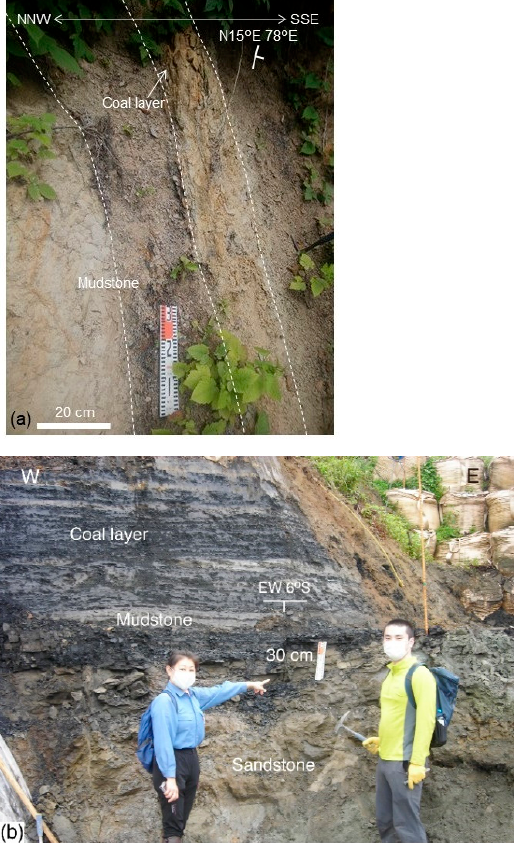
Figure 2. Outcrop photographs of the Shakubetsu Formation. ( a ) Steeply dipping strata located at the northwest of flexure (outcrop KT5). The bedding plane is shown by dashed lines. ( b ) Almost horizontally dipping strata located at the southeast of flexure (outcrop KT2), where the sandstone sample for image analysis is collected. See Figure 1b for the localities.